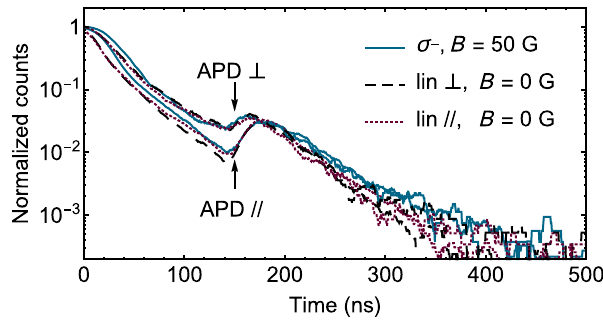
FIG. 5. Directionality of the emitted light pulse. Release of the subradiant excitation, observed with light collected axially (APD//) (bottom curves) and radially (APD ⊥ ) (top curves). The experiment is performed with a linear polarization of the excitation light, either parallel (dotted lines) or perpendicular (dashed lines) to the cloud, and with a circular polarization in the presence of a 50-G magnetic field aligned along the excitation direction (solid